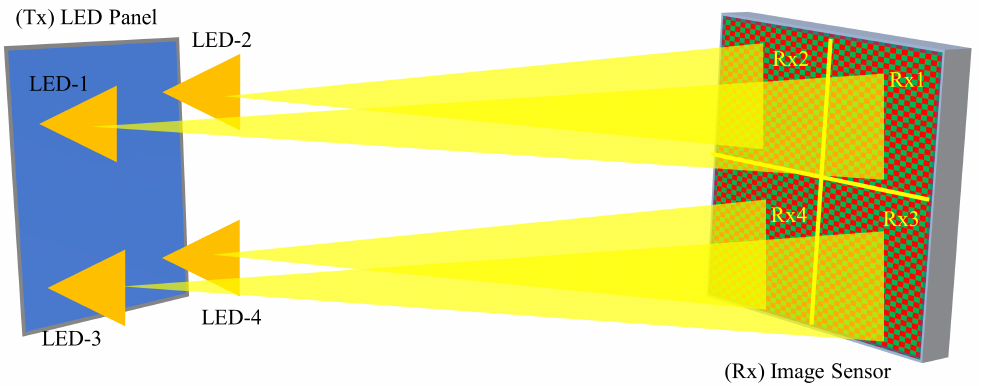
Figure 8. 4 × 4 MIMO optical camera